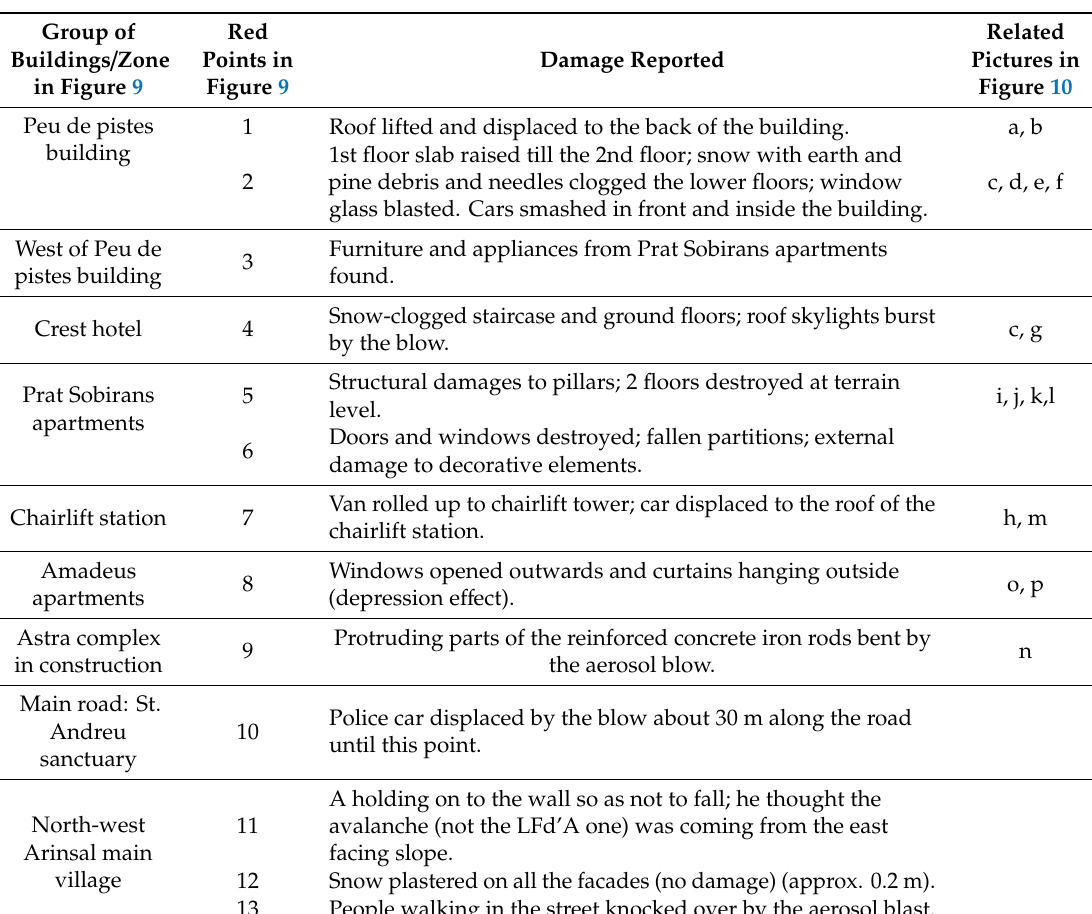
Table 1. Summary of the damage mapped in Figure 9 and related pictures in Figure 10 that illustrate some of this damage, arranged by zones and groups of buildings.